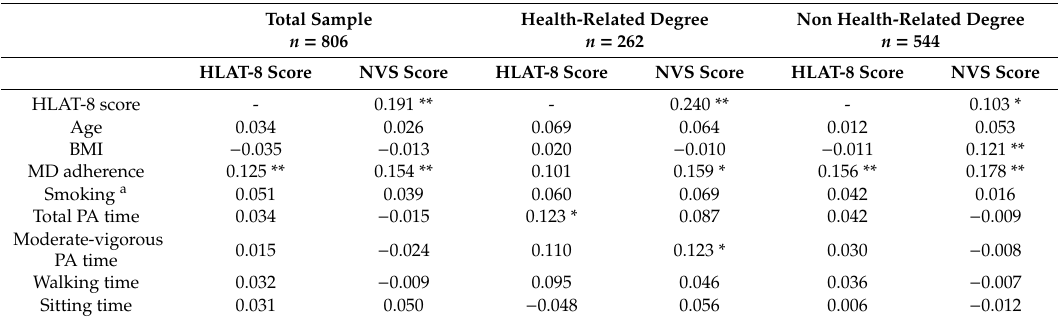
Table 2. Results of correlations between HL scores and students’ information in the total sample and in the two subgroups.